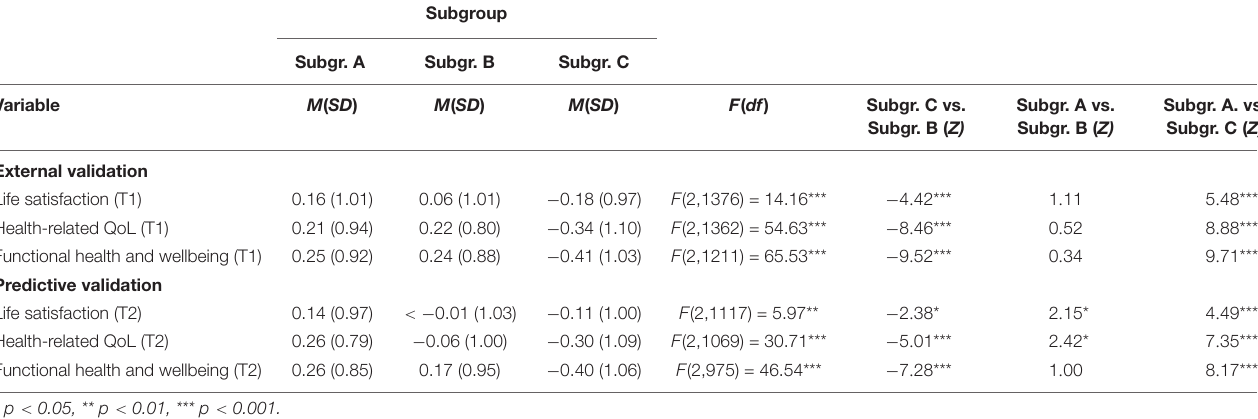
TABLE 3 | Scores related to subjective cognitive decline for external (T1) and predictive (T2) validation for each of the three community detection-based subgroups formed on T1 data.